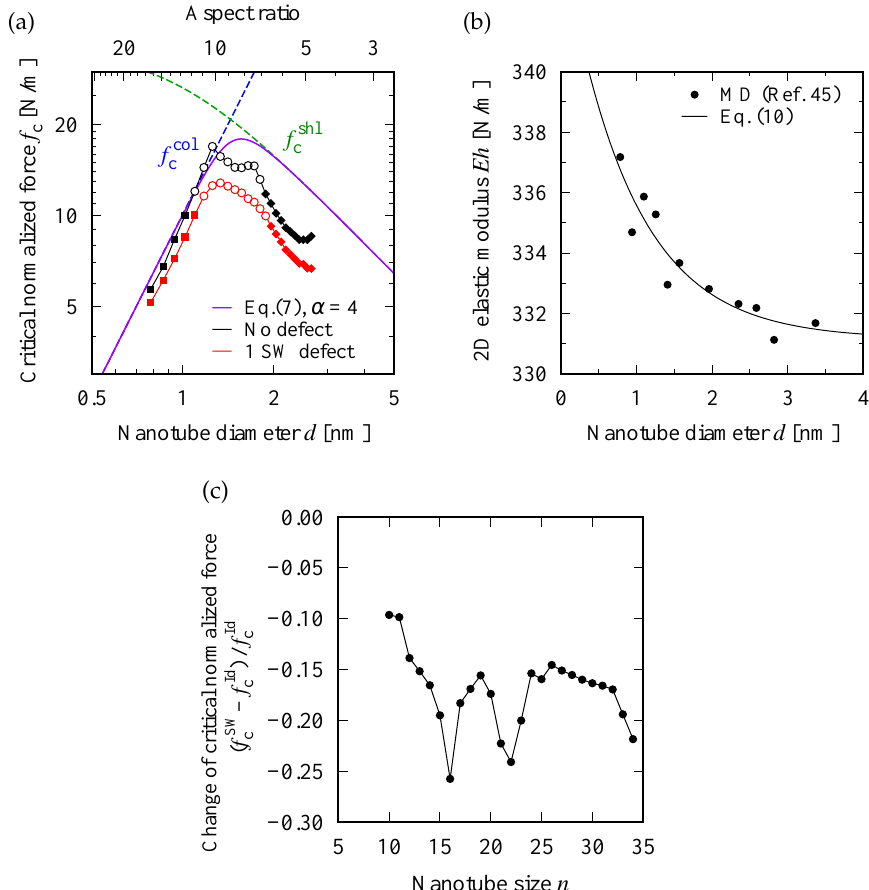
Figure 5. ( a ) Logarithm plot of f c ( d ) as a function of tube diameter d . Two dashed curves, labeled by f col c and f shl c , are deduced from Equations (3) and (6), respectively. The solid curve corresponds to the approximated expression expressed as Equation (7) with the parameter setting of α = 4.0. ( b ) Numeric data of Eh obtained by MD simulations published in Ref. [47]. An exponential fitting curve to the data point, calculated by a nonlinear least square method, is depicted by a solid curve; the explicit functional form is provided in the text. ( c ) Reduction in the critical buckling normalized force caused by insertion of a SW defect; f SW c and f Id c are the value of f c for defective and defect-free SWNTs,